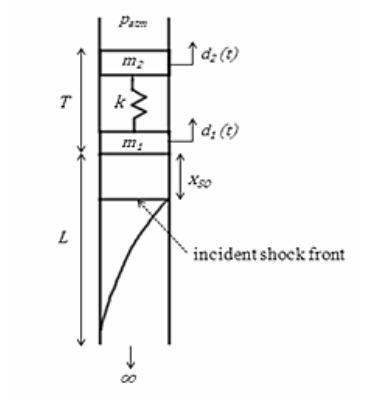
Fig. 3. Schematic of the mass-spring oscillator UNDEX